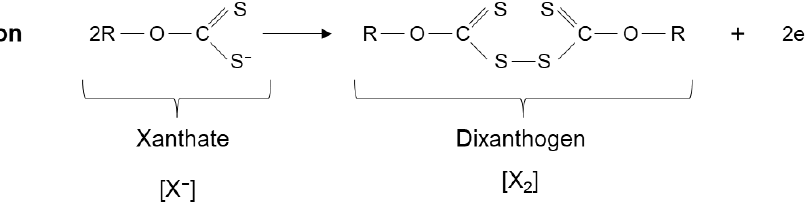
Figure 10. Formation of carbon sulfide at different pH values from 0.05 wt% SIBX solution (adapted from Shen et al. [33]).